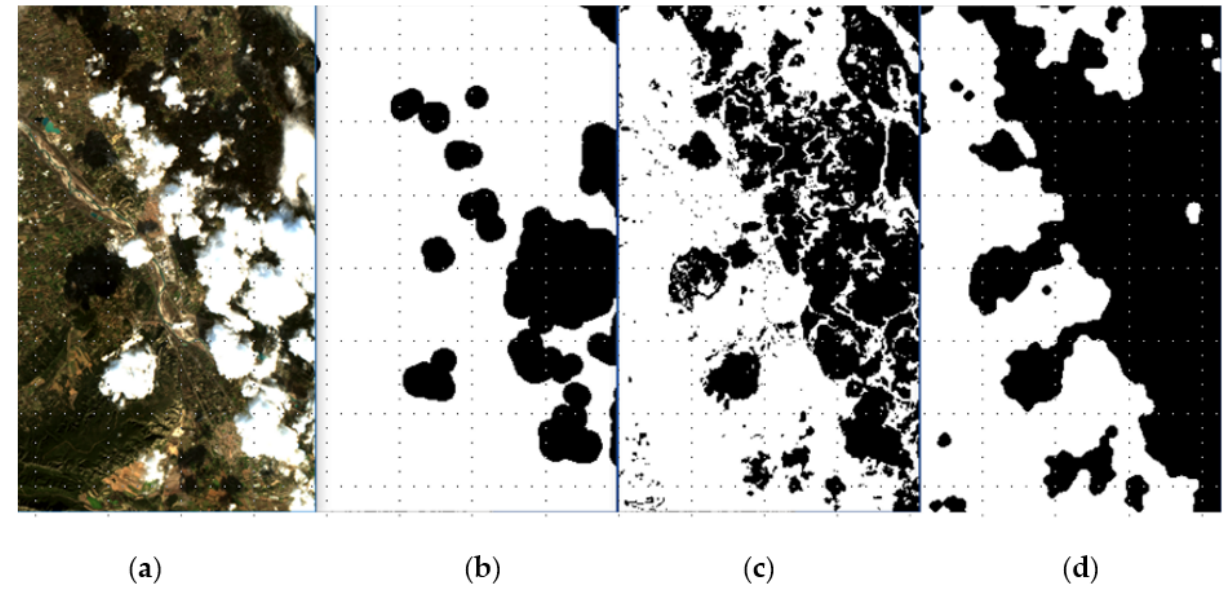
Figure 7. Differences between the S2 L1C and L2A cloud masks: ( a ) RGB image, ( b ) L1C cloud mask (inverted), ( c ) L2A cloud and shadow mask and ( d ) post-processed cloud and shadow mask (cleaned and